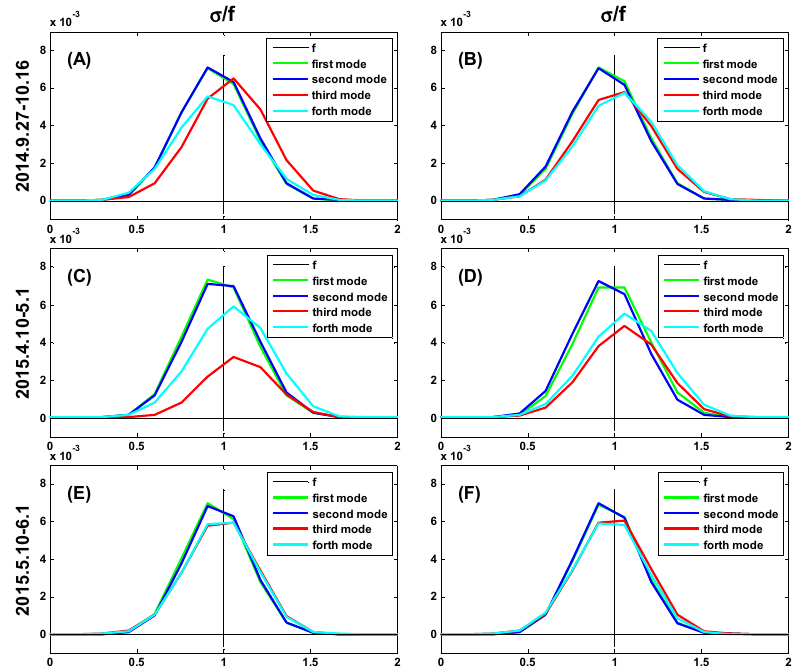
Figure 11. Power spectra of the ( A , C , E ) eastward and ( B , D , F ) northward time series of the near-inertial currents in the three NIOs by EOF analyses results. The power spectra of the first NIO event is shown in ( A , B ). The second is shown in ( C , D ). The third is shown in ( E , F ). The horizontal axis of the figure is the relative frequency of the Coriolis frequency f . The vertical axis is spectral density with the unit m 2 s − 2 cpd − 1 . Each picture has the time series result of the first four modes by EOF analyses.